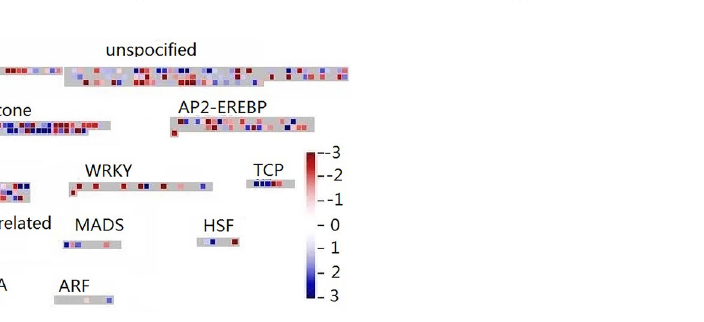
Figure 4. Analysis of hormonal metabolic pathways of differentially expressed genes (DEGs) involved in lateral bud differentiation. ( a ) Auxin synthesis pathway; ( b ) Abscisic acid synthesis pathway; ( c ) Cytokinin synthesis pathway; ( d ) Jasmonic acid synthesis pathway; ( d ) Metabolic pathway of gibberellin, ethylene, brassinosteroid, and salicylic acid. The FPKM ratio of unigene expression was represented on a logarithmic scale for each treatment (T, L, K). Red indicated that a gene was up-regulated at that stage, whereas green indicated down- regulated expression. The heat map was conducted by morpheus (https:// softw are. broad insti tute. org/ morph eus/).